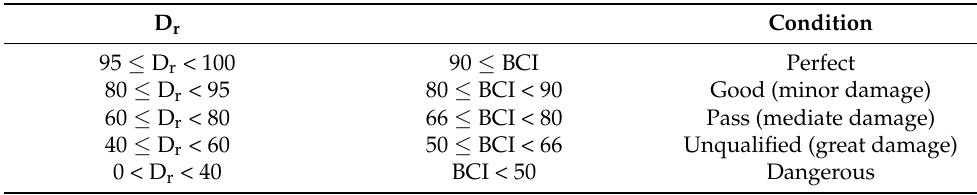
Table 1. Assessment of bridge condition in China.